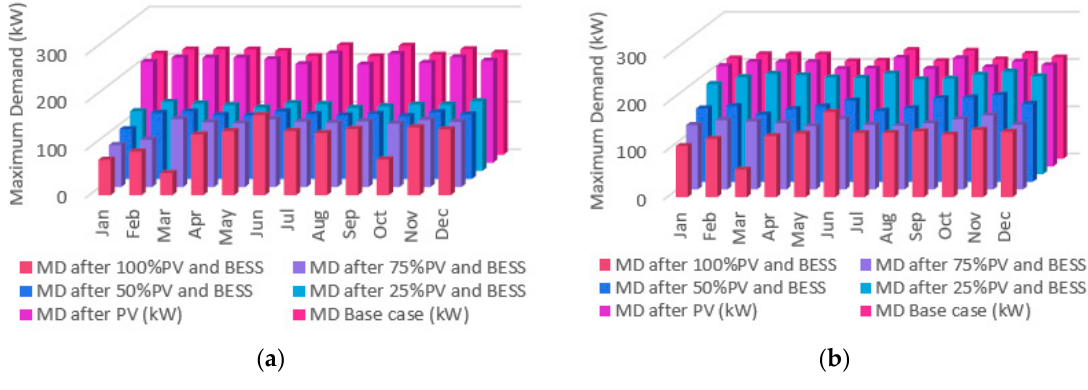
Figure 15. Maximum demand reduction in kW for both scenarios: ( a ) PVGS and ( b ) RFPS.